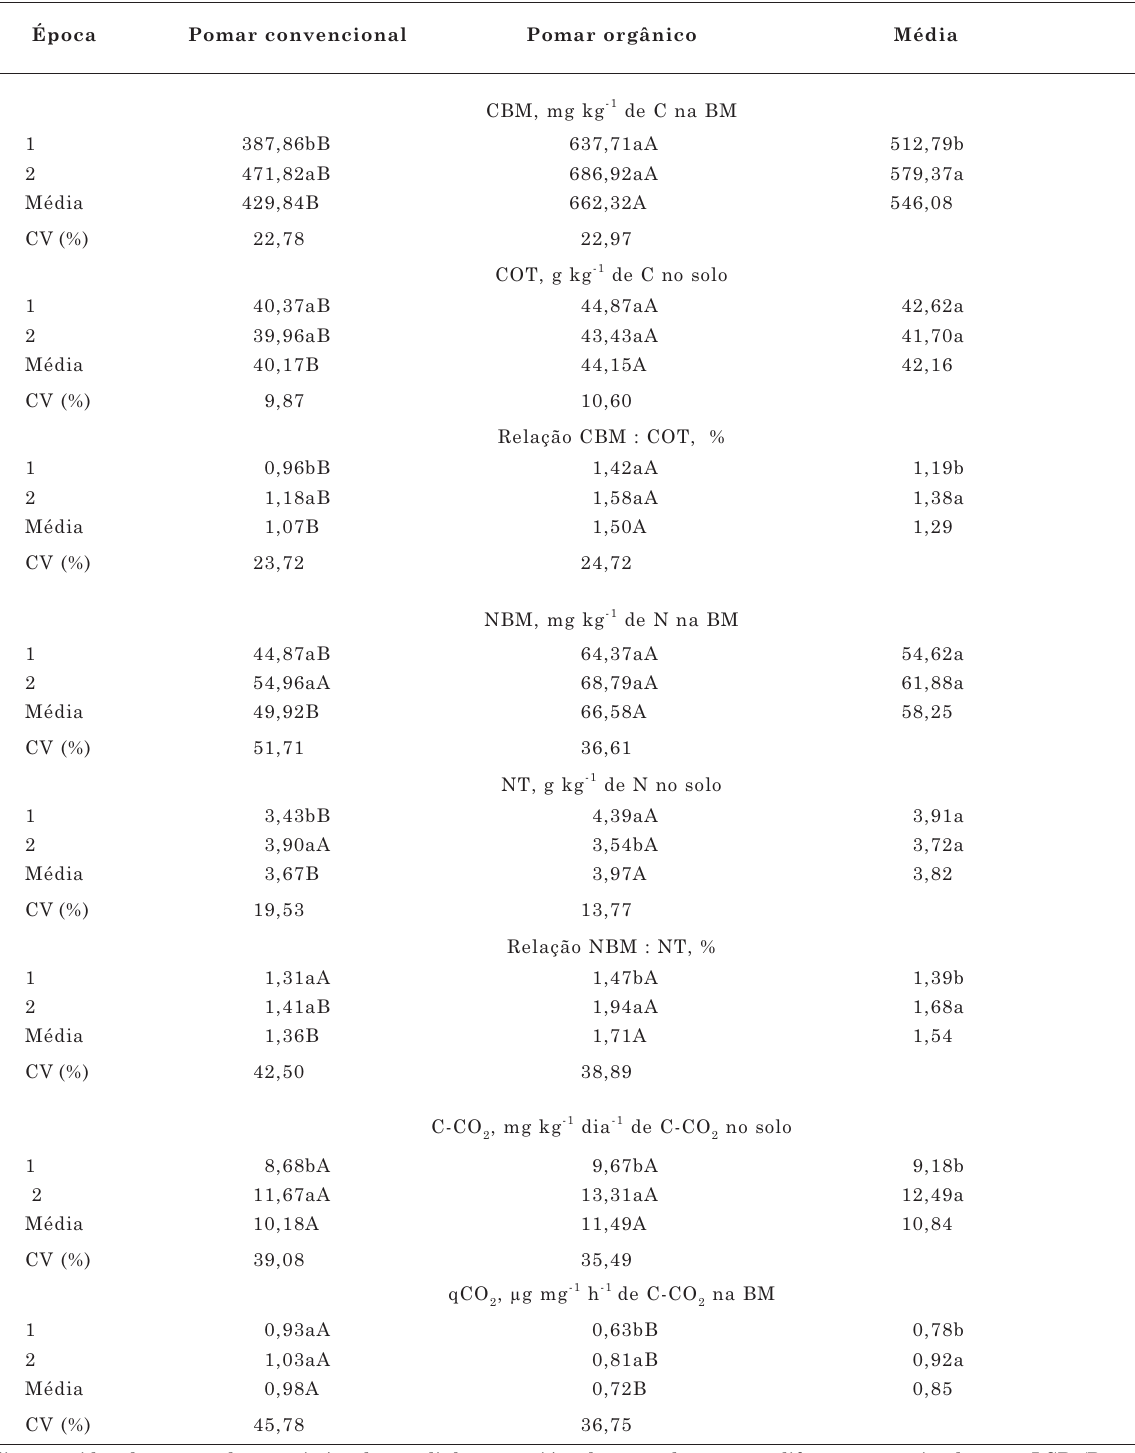
tal. CV = coeficiente de variação em relação à